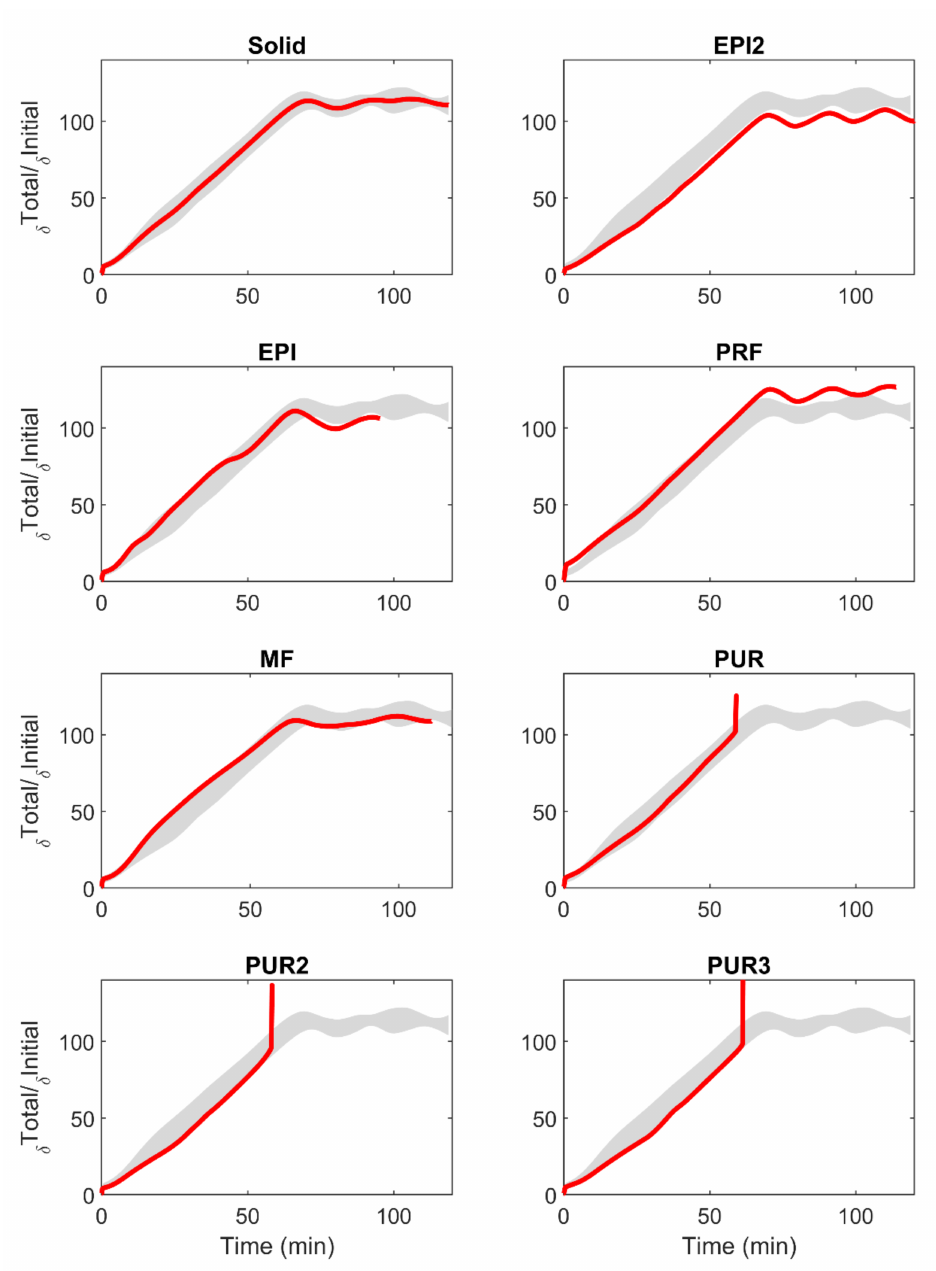
Figure 5. The average curve of all the adhesives, compared with solid wood. The averaged curve of each treatment is represented in (red) with the shaded (grey) area indicating +/ − 1 standard